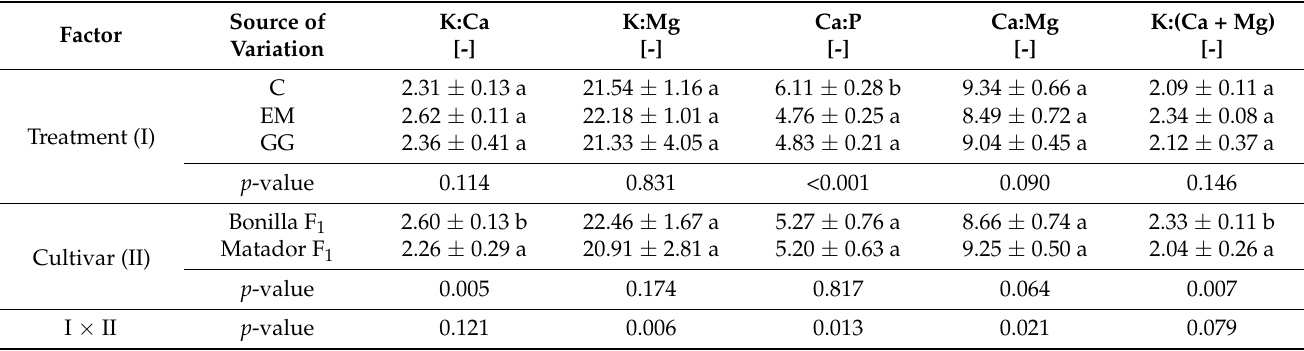
Table 9. Macronutrient ratios in shallot